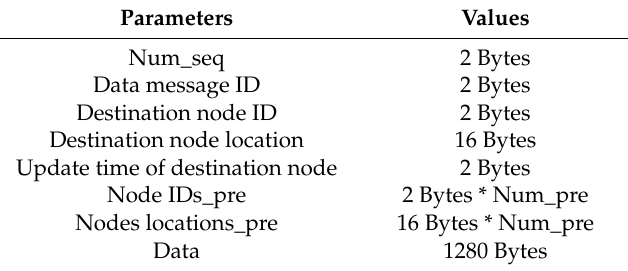
Table 3. Format of data message.